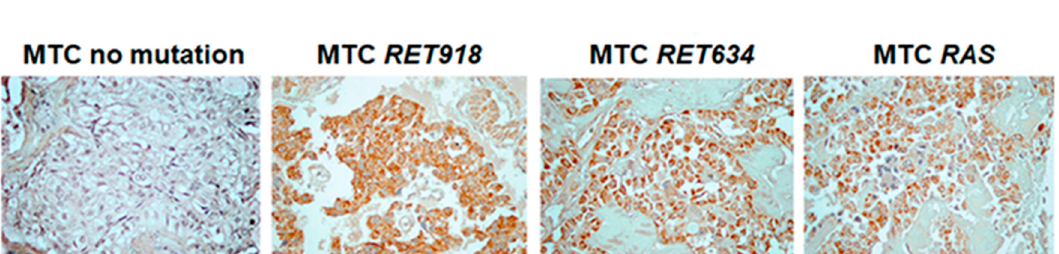
Figure 2. COX4 expression in human medullary thyroid tissue samples. Immunostaining with anti-COX4 indicating minimal expression of COX4 in MTC without detectable RET and RAS mutations. Strong, homogeneous cytoplasmic expression in MTC samples harboring RET and H2RAS mutations (magnification, ×400).